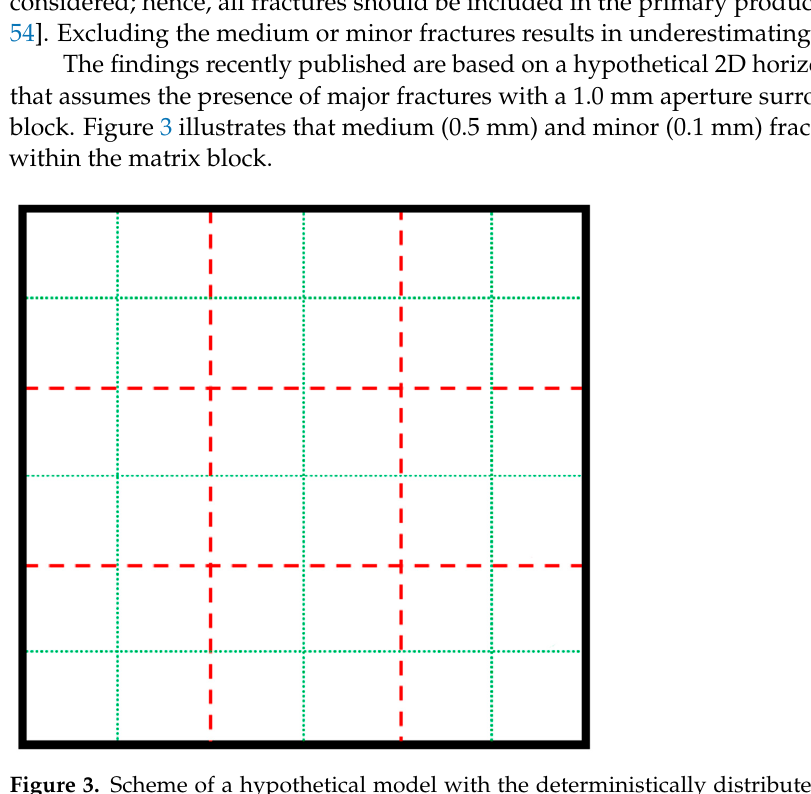
Figure 3. Scheme of a hypothetical model with the deterministically distributed fractures (black: major; red: medium, green: minor fractures).